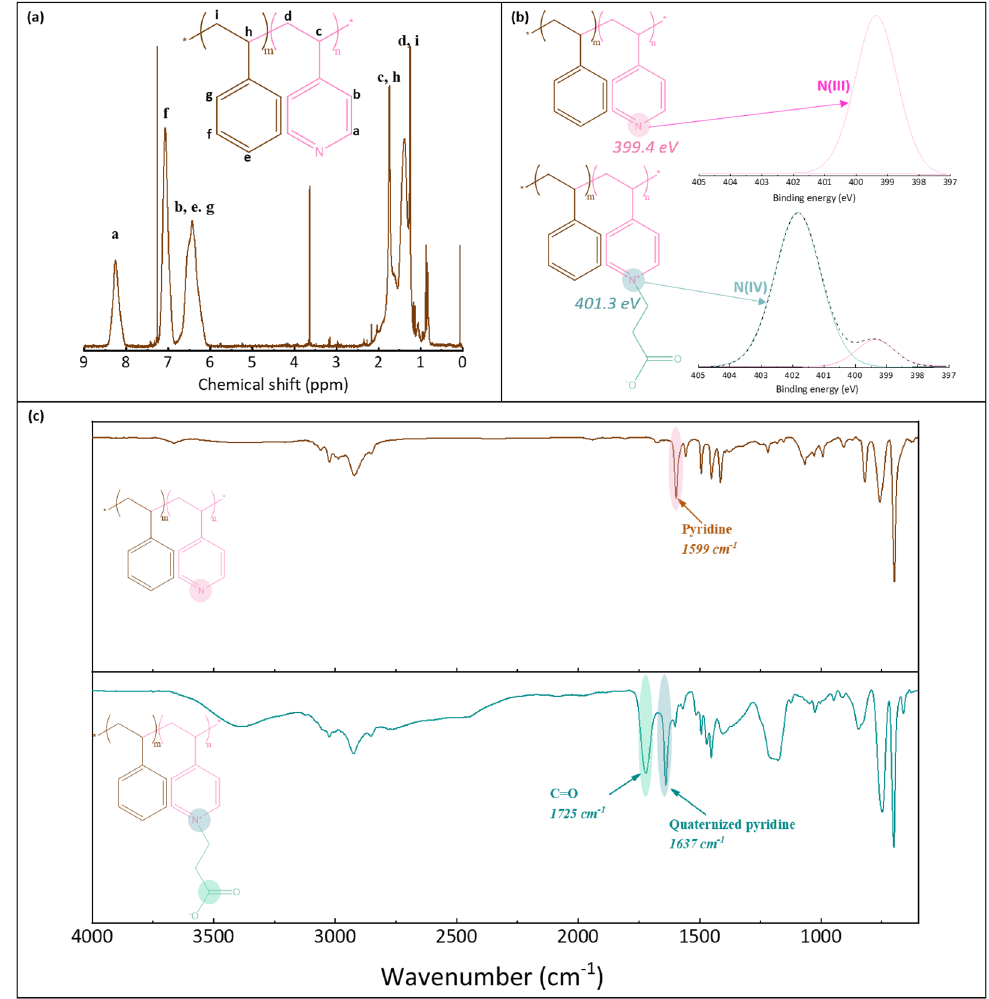
Figure 2. Characterization of poly(styrene- r -4-vinylpyridine) and zwitterionic poly(styrene- r -4-vinylpyridine) copolymers. ( a ) 1 H NMR spectrum of P(S- r -4VP), ( b ) N1s core-level spectra of P(S- r -4VP) and zP(S- r -4VP), ( c ) FT-IR spectra of P(S- r -4VP) and zP(S- r -4VP).